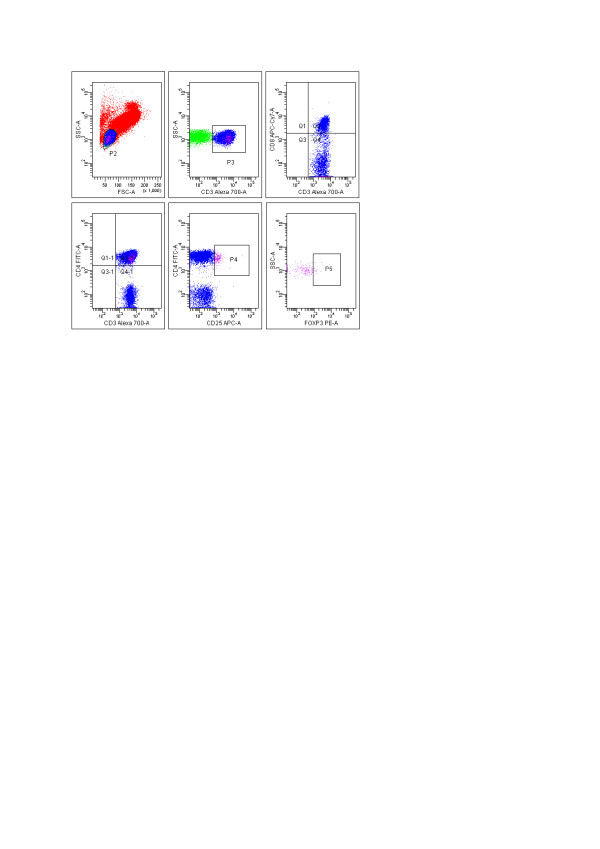
Characterization of T lymphocyte, T-helper, T-cytotoxic and foxP3 expressions. Lymphocytes had been selected from side/forward scatter and CD3, CD3CD4, CD3CD8 cells detected by using sequential gating. CD25+ foxP3+ TREG cells were shown within the CD4+ T cell population.